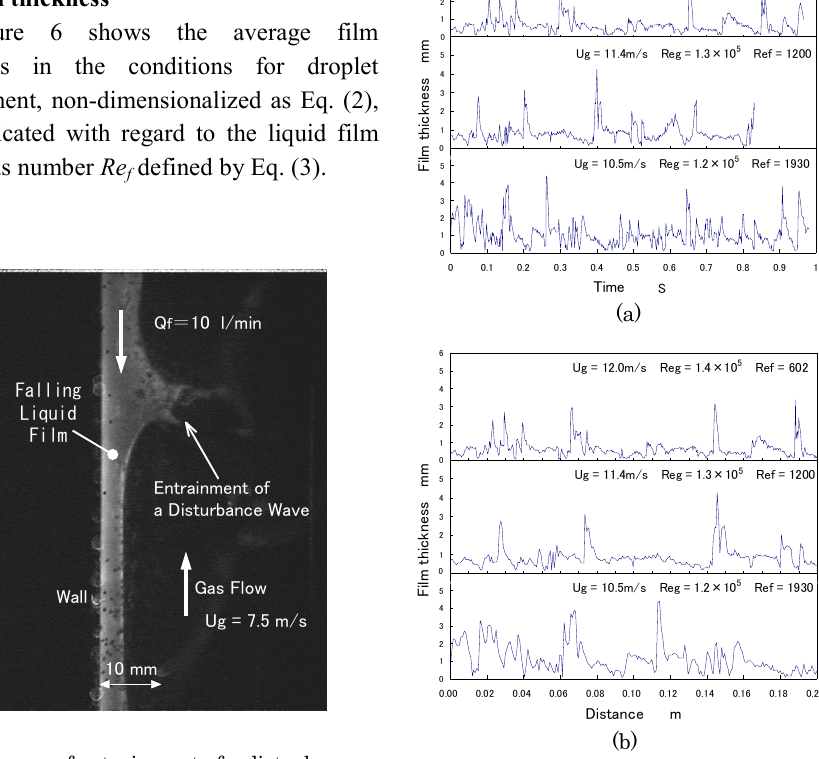
Fig.3 Variation of film thickness